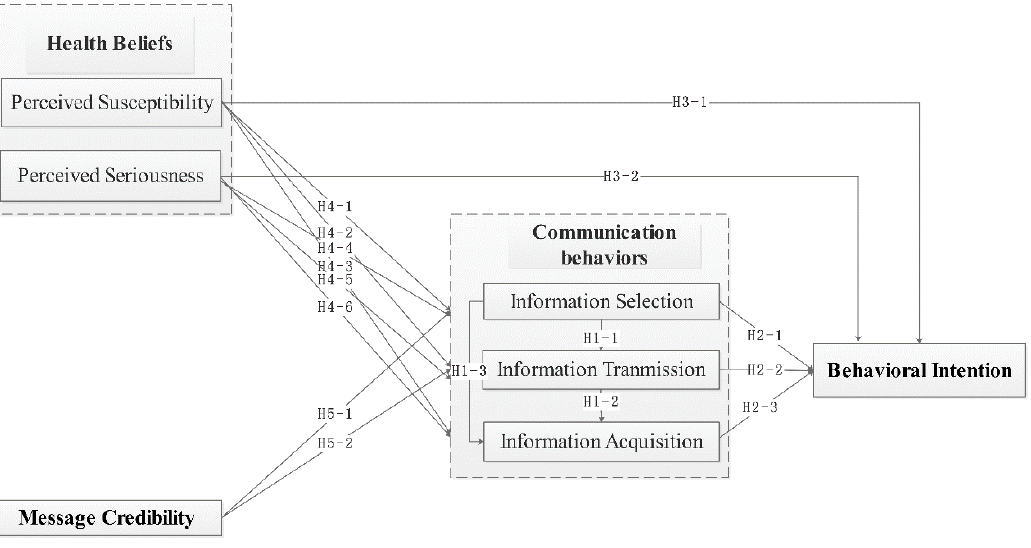
Figure 1. Conceptual model.